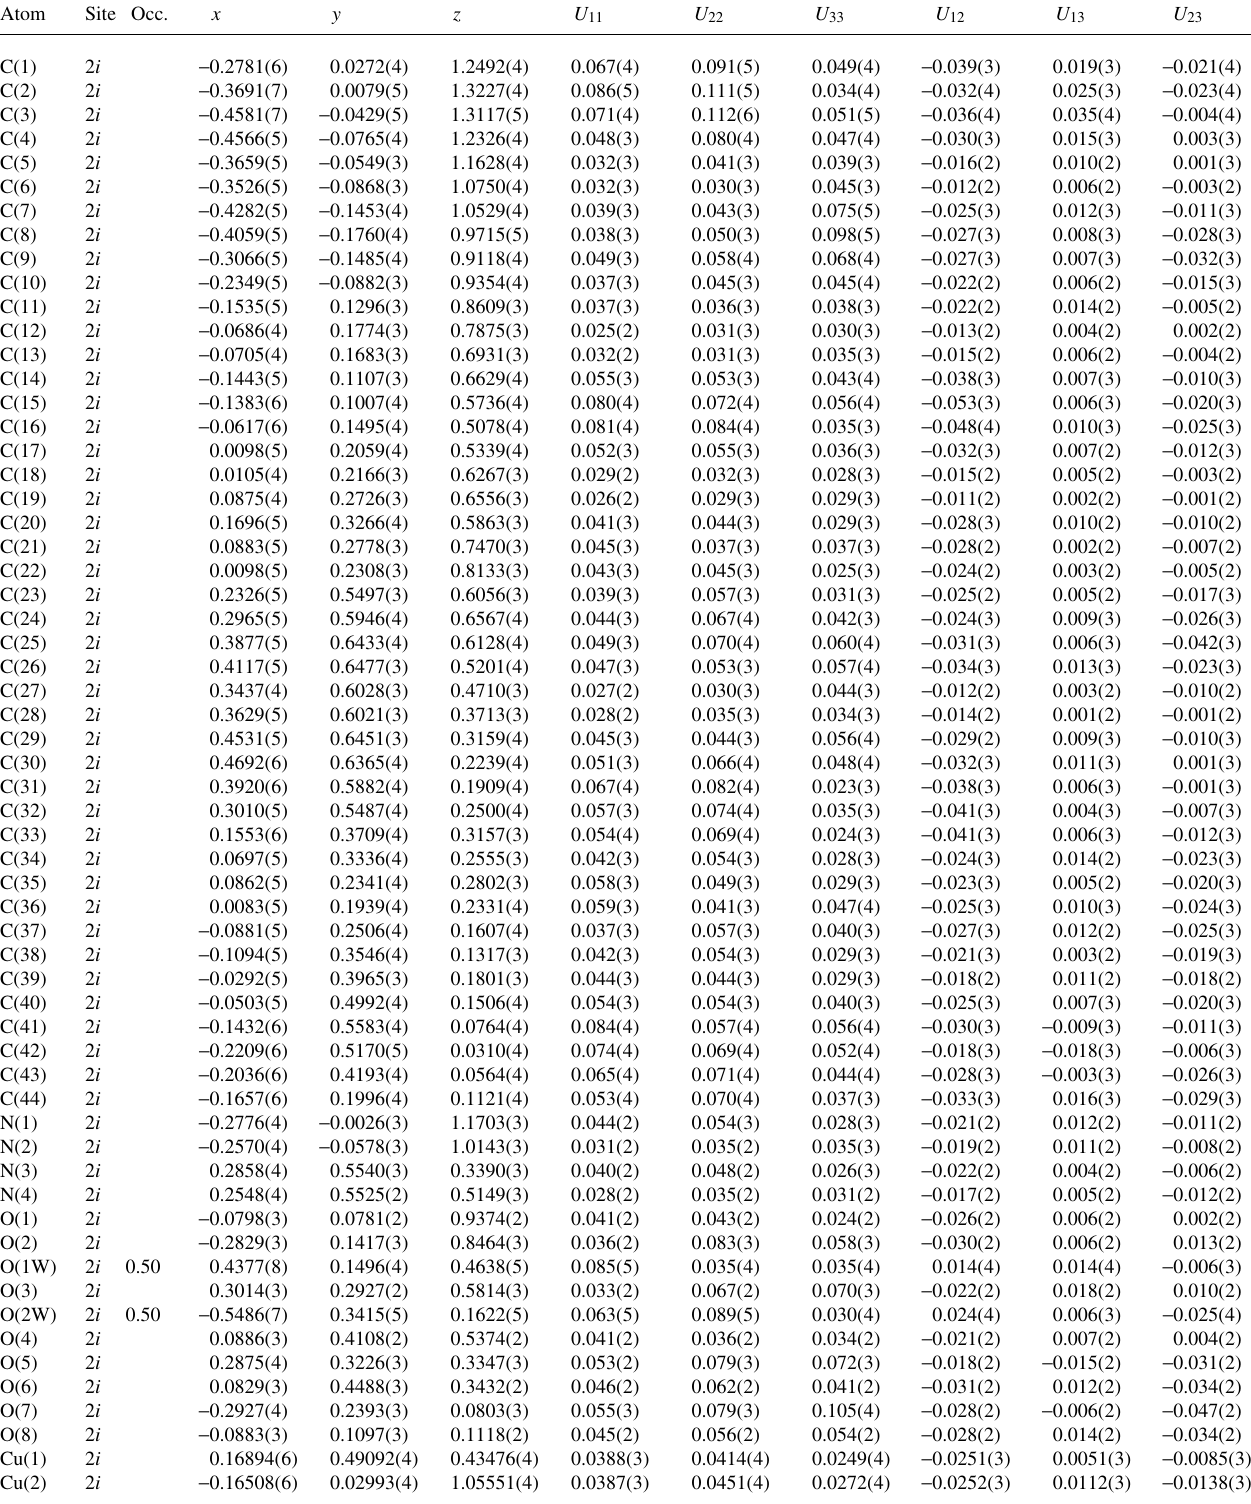
Table 3. Atomic coordinates and displacement parameters (in Å 2 ) . Atom Site